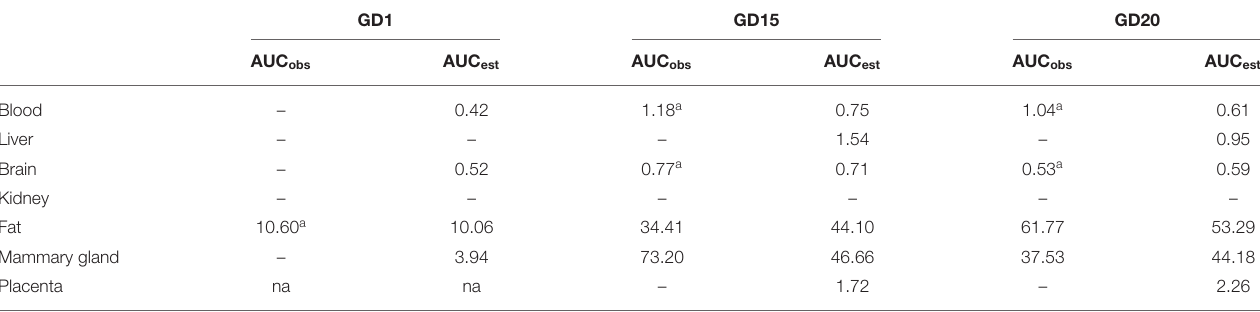
TABLE 5 | Area under the curve ( µ g h/ml or µ g h/g) of the observed concentrations (AUC obs ) and the estimated concentrations (AUC est ) for trans -permethrin in the blood and tissues of pregnant